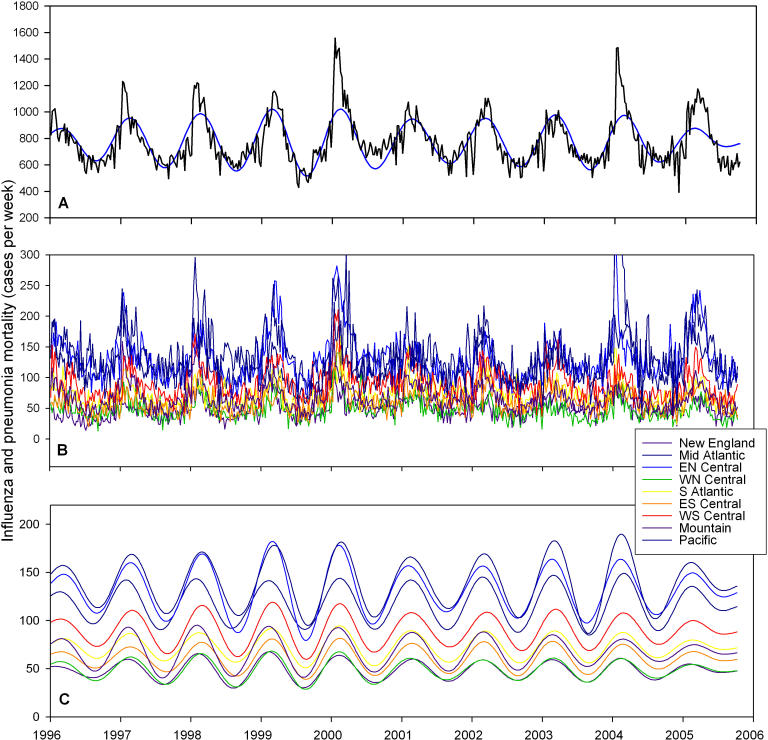
Filtering of Weekly P&I Mortality in the United States (1996–2005)(A) The black line represents the aggregated national data of P&I weekly mortality. The blue line represents the seasonal influenza curve, derived by band-pass filtering the demeaned data (two-pole, two-pass Butterworth, 1/64–1/40 frequency range). For comparison with the raw data, the mean is added after filtering. The filtered time series plus mean accounts for 99.8% of the mortality, indicating that most deaths are from the mean and seasonal variation and not the high-frequency cycles.(B) Lines represent the raw time series data for each of the nine geographic regions of the US.(C) Lines represent the seasonal influenza curves for each of the nine geographic regions of the US, derived by band-pass filtering.